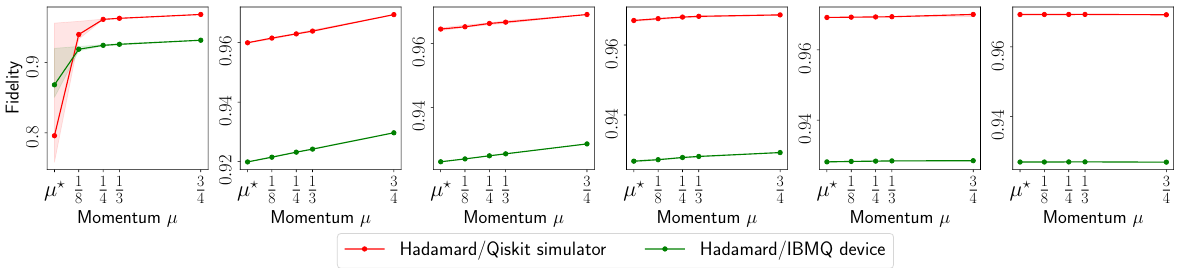
Figure A20. Fidelity list plots for reconstructing Hadamard ( 8 ) circuit using using real measurements from IBM Quantum system experiments and synthetic measurements from Qiskit simulation experi-